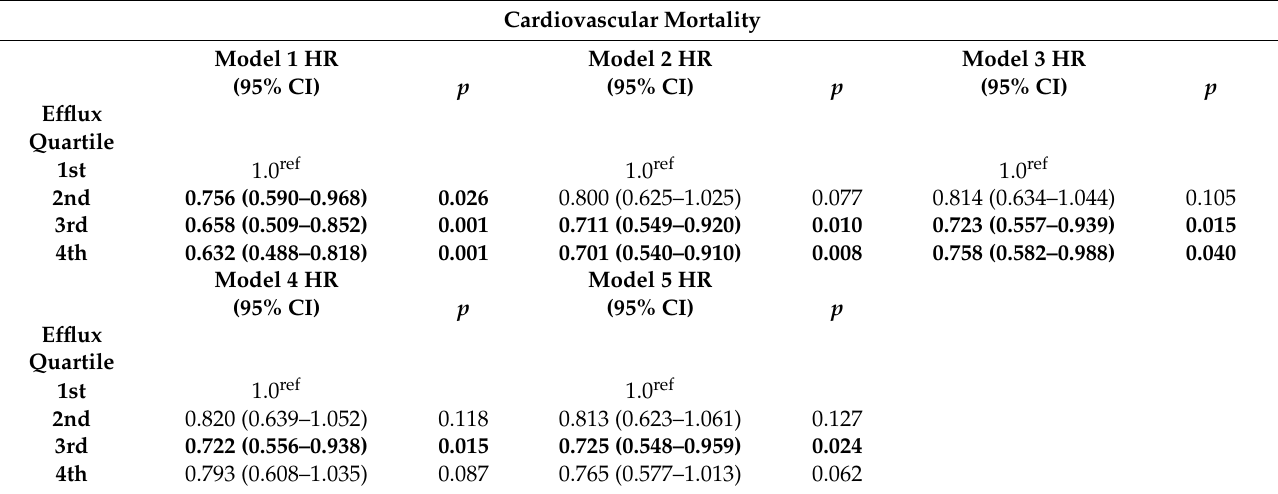
Table 2. Hazard ratio for cardiovascular death according to cholesterol